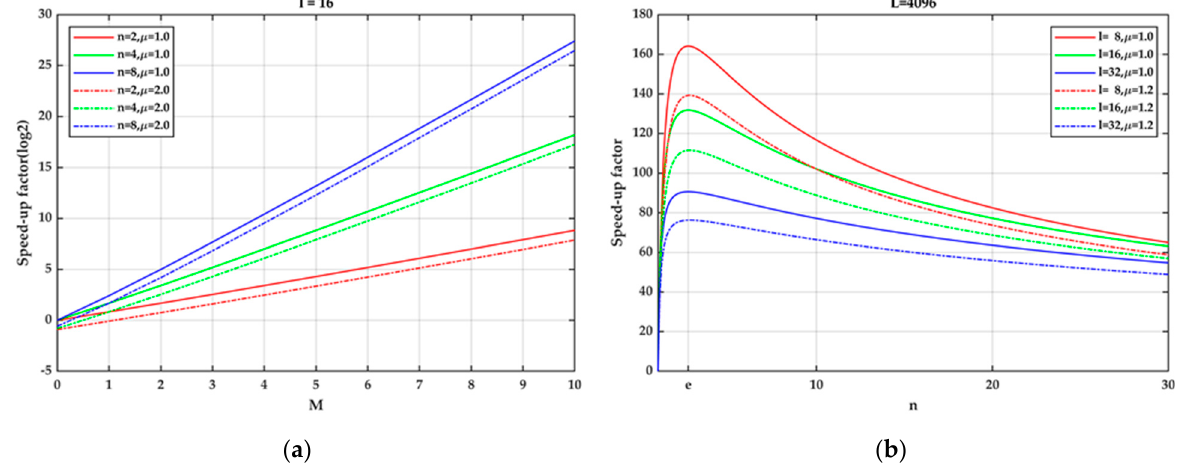
Figure 8. Variation of the speed-up factor. ( a ) With respect to the fusion time M ; ( b ) With respect to the fusion aperture n .